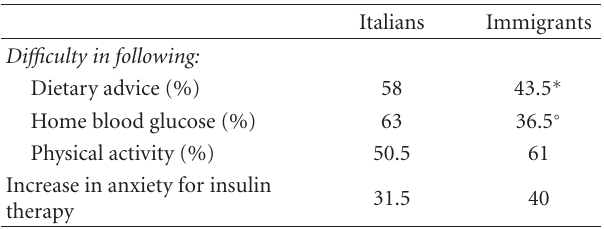
Table 2: Di ffi culties and anxiety related to diabetes monitoring. Italians Immigrants